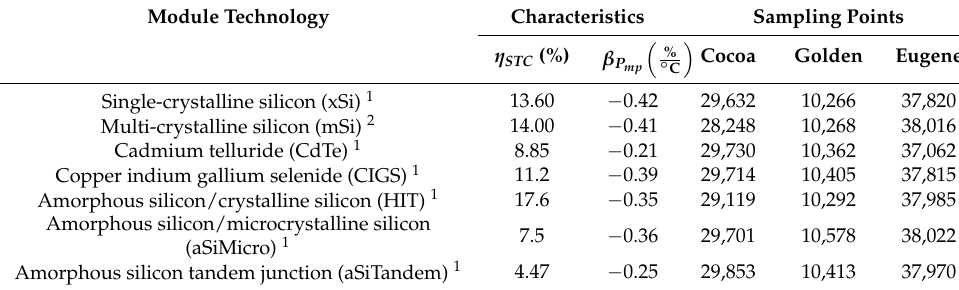
Table 2. Technologies and main characteristics of the different